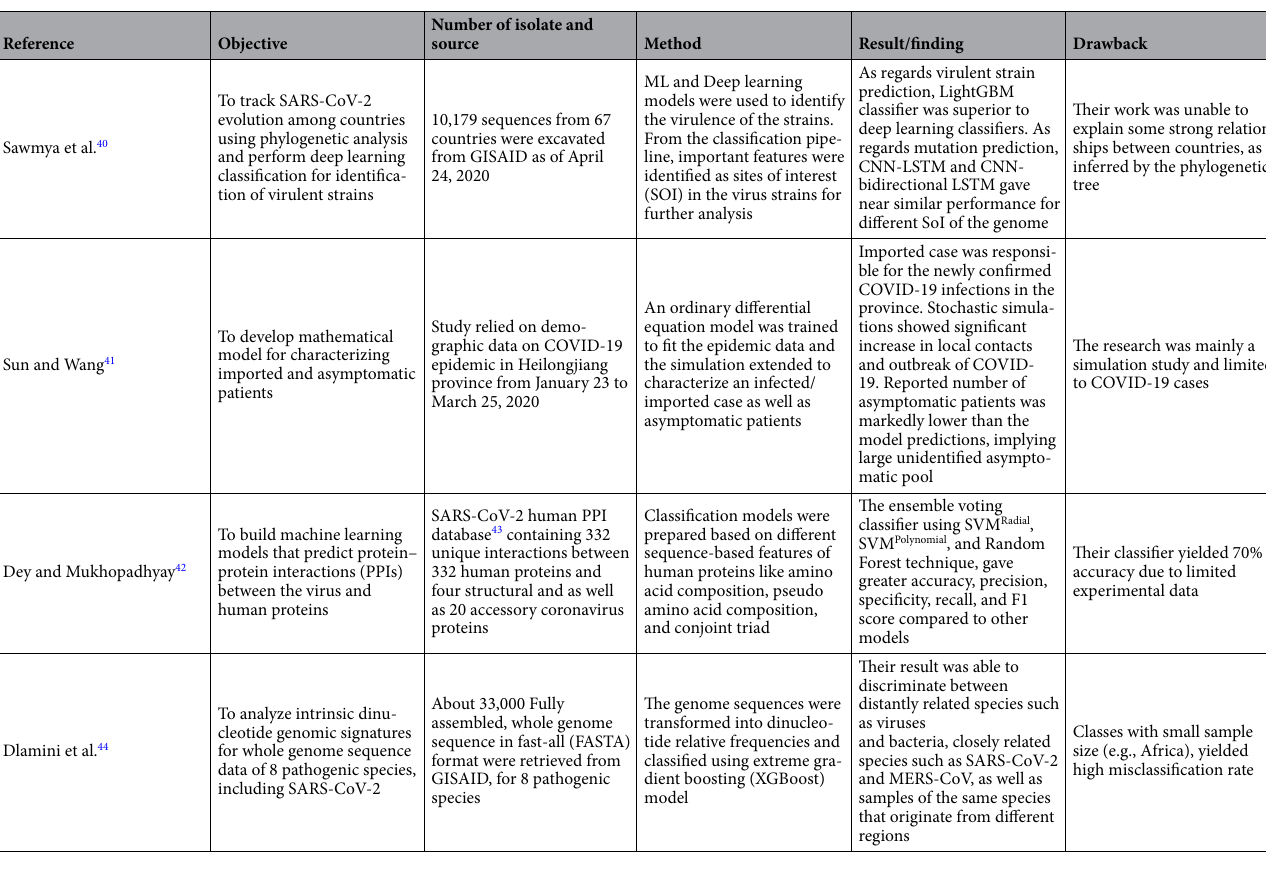
Table 1. Summary of ML/AI application of SARS-CoV-2 characterization and